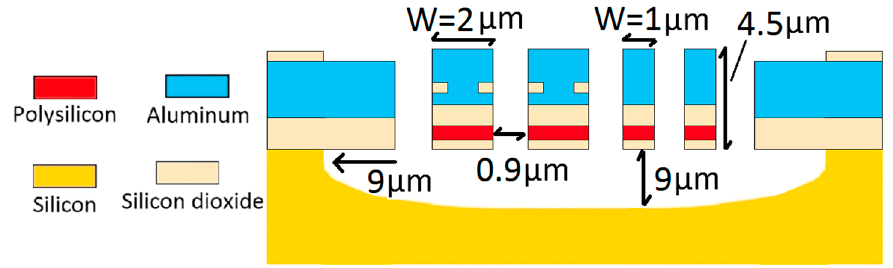
Figure 1. The cross section for Device 1 (W = 2 µm) and for Device 2 (W = 1 µm), where W is the thickness.